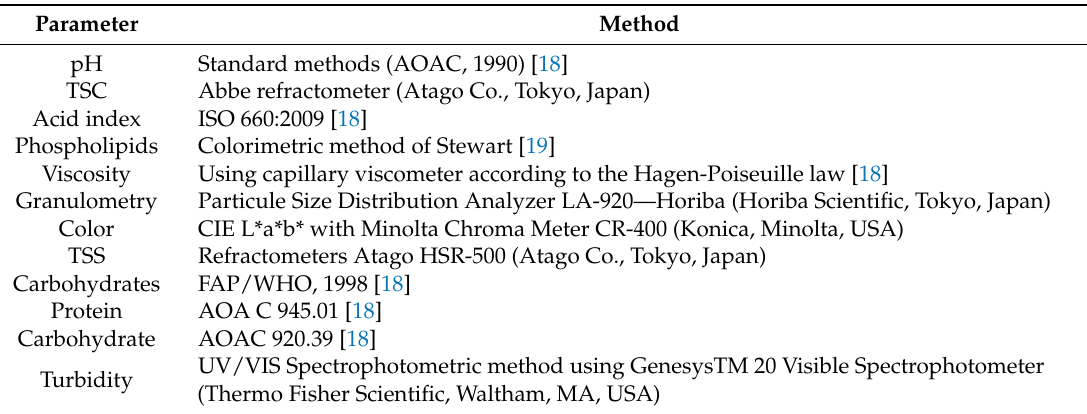
Table 1. Method for physiochemical analysis.